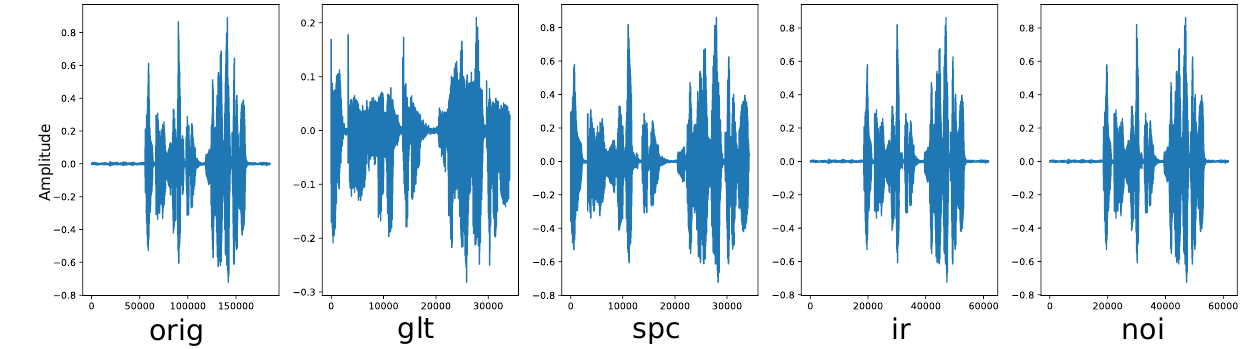
Figure 3. Plots of the original and augmented data from a sample in JTES dataset.